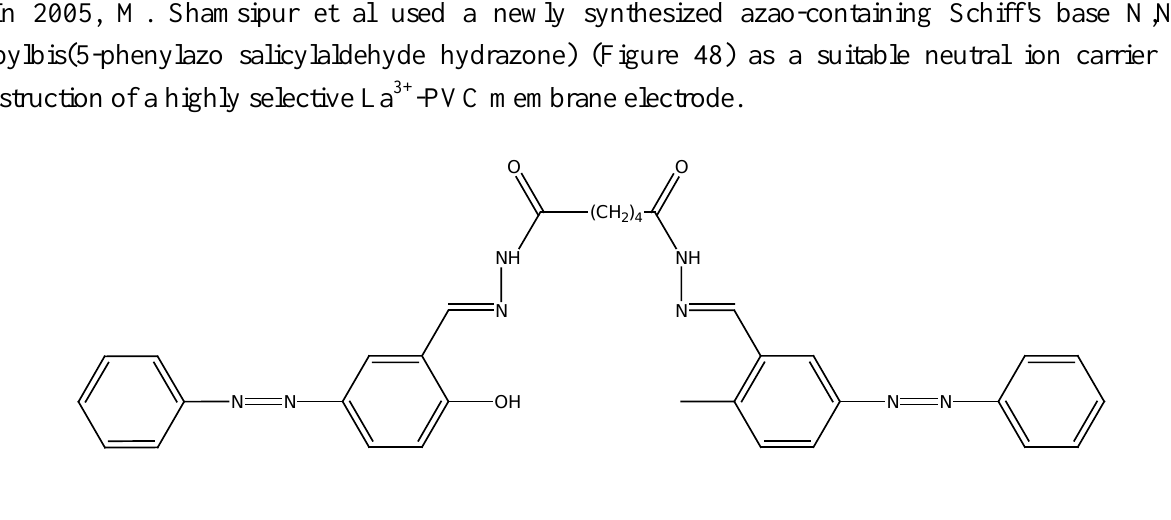
Figure 48. Schiff's base N,N'-adipylbis(5-phenylazo salicylaldehyde hydrazone). The electrode exhibited a Nernstian response with a slope of 19.4 mV decade -1 over a wide